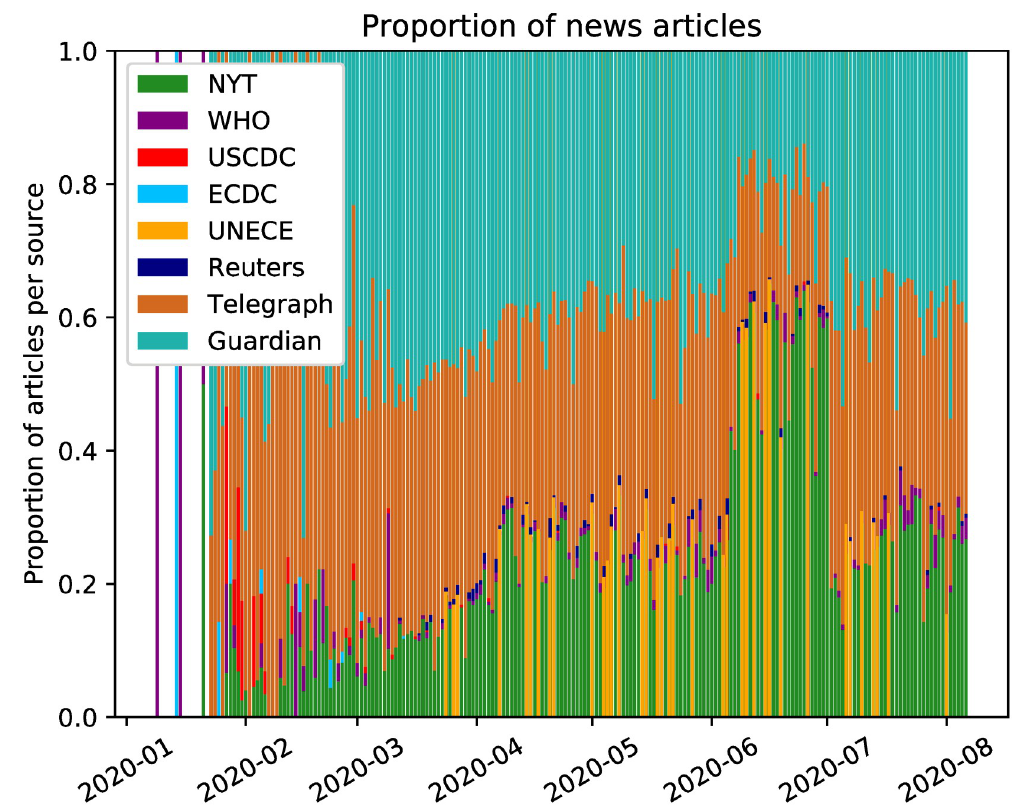
Fig 5. Proportion of news articles. Proportion of volume of news reports per news